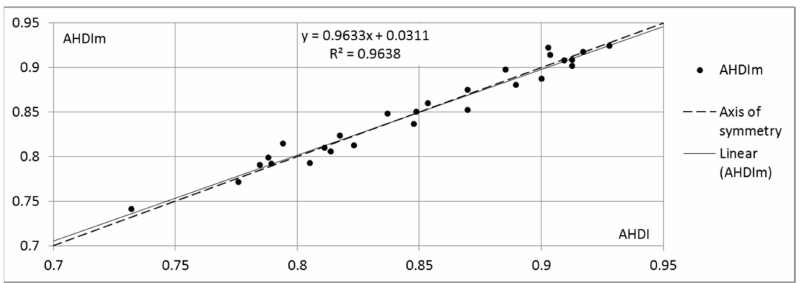
Figure 6. Regularity of the final non-linear model AHDIm vs. AHDI. Developed by authors.